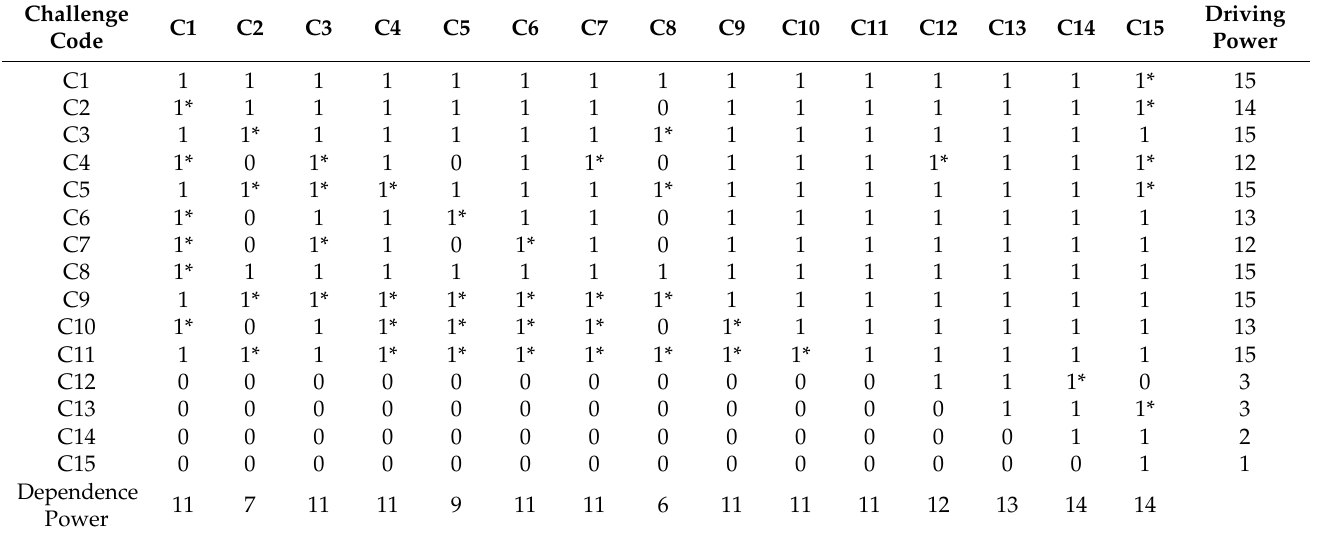
Table 6. Final reachability